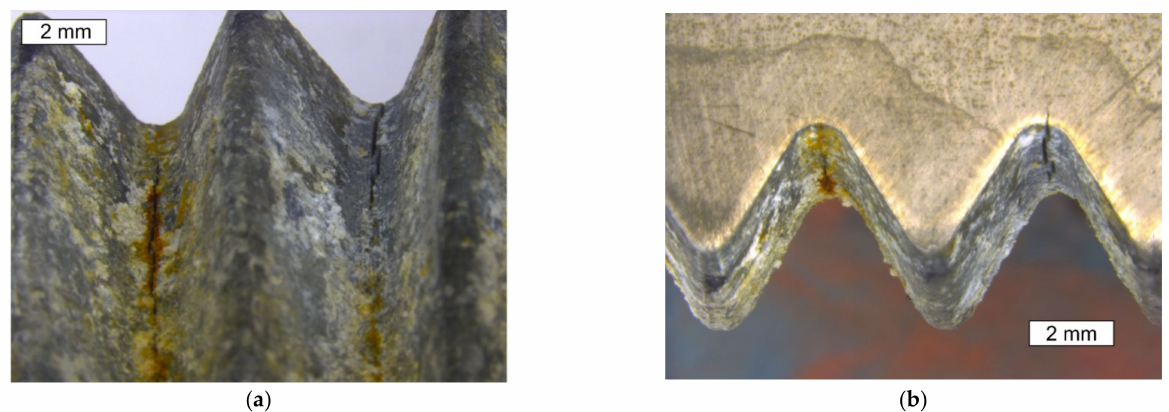
Figure 7. Stereoscopic image of the macro section taken at the longitudinal section of the S2 thread. Visible cracks running along the thread roots, as well as white and red corrosion symptoms: ( a ) area 1, ( b ) area